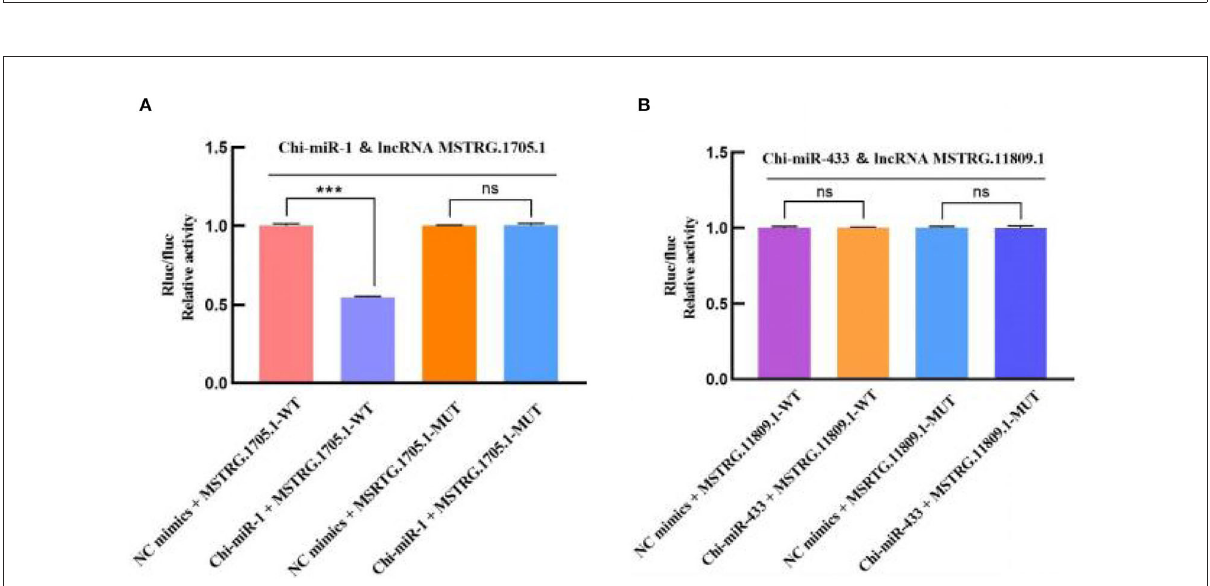
FIGURE11 Dual-luciferase verification of the binding relationship between lncRNA-miRNA. (A) Detection of interaction between lncRNA MSTRG.1705.1 and Chi-miR-1 by dual-luciferase reporter gene assay. (B) Detection of interaction between lncRNA MSTRG.11809.1 and Chi-miR-433 by dual-luciferase reporter gene